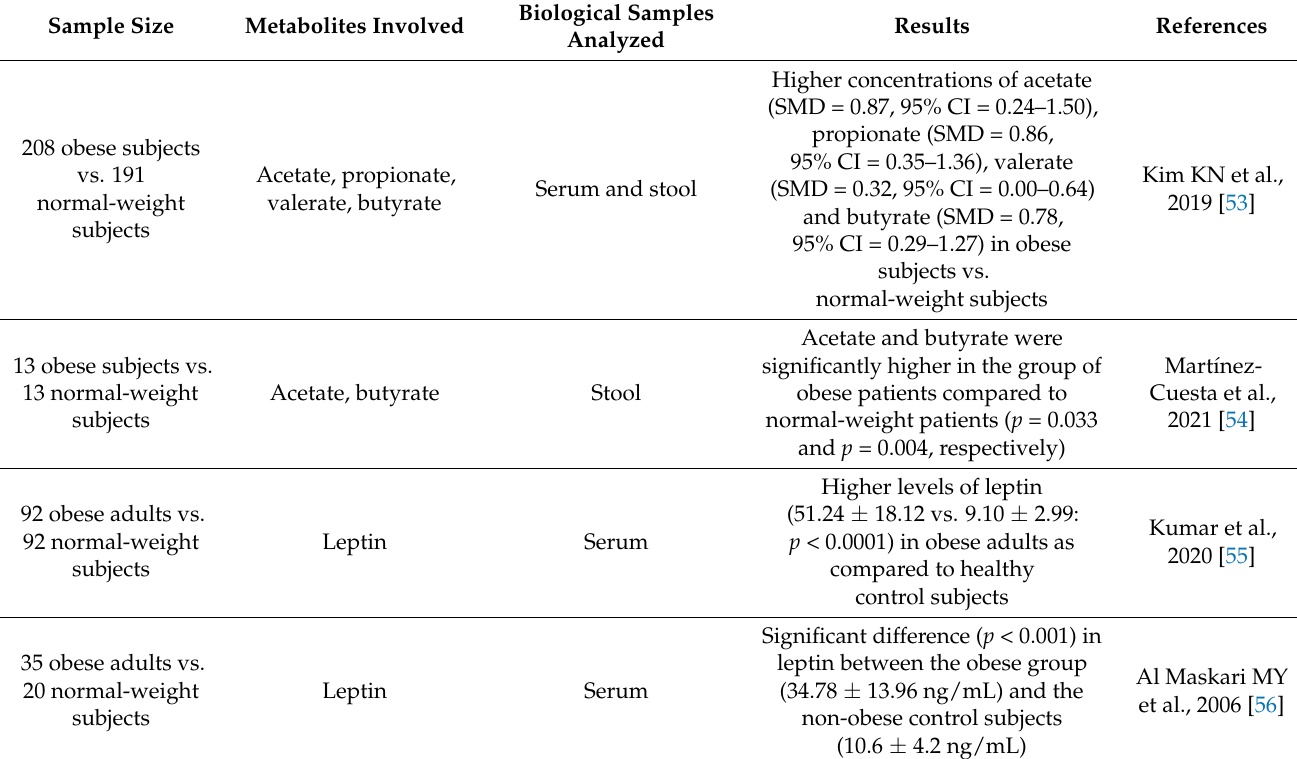
Table 1 summarizes case-control studies regarding metabolite production and obesity. Table 1. Summary table of case-control studies regarding metabolite production and